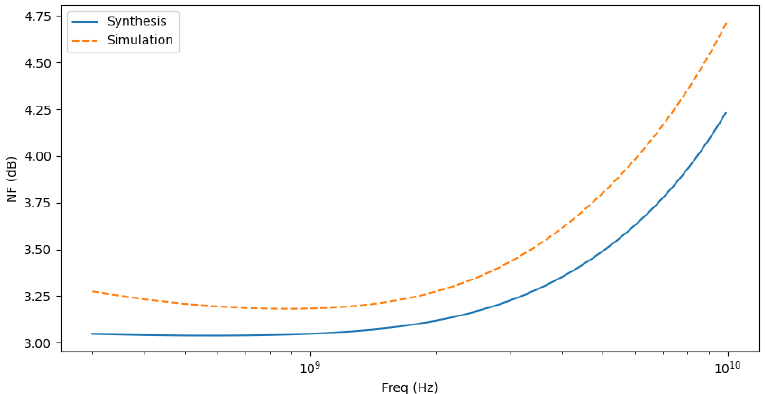
Figure 11. NF (dB) vs. frequency (Hz) for the first design point nominal corner.